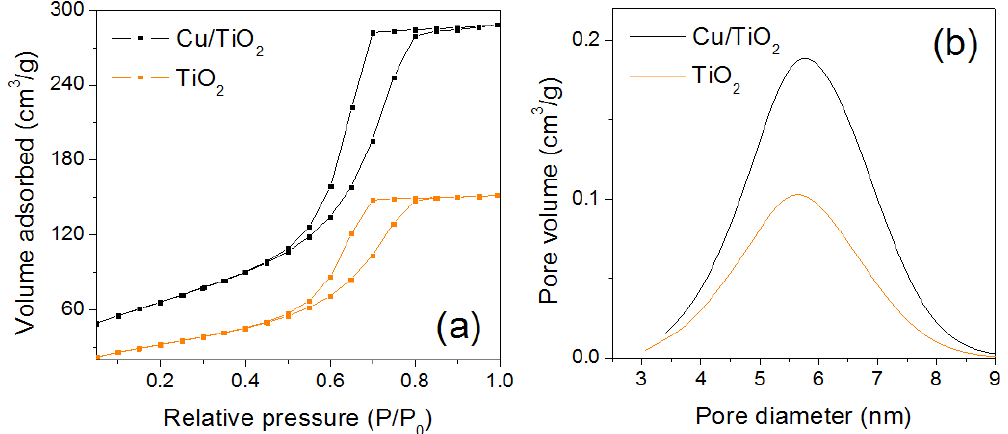
Figure 1. ( a ) N 2 adsorption-desorption isotherms and ( b ) pore size distributions of Cu/TiO 2 and TiO 2 catalysts.